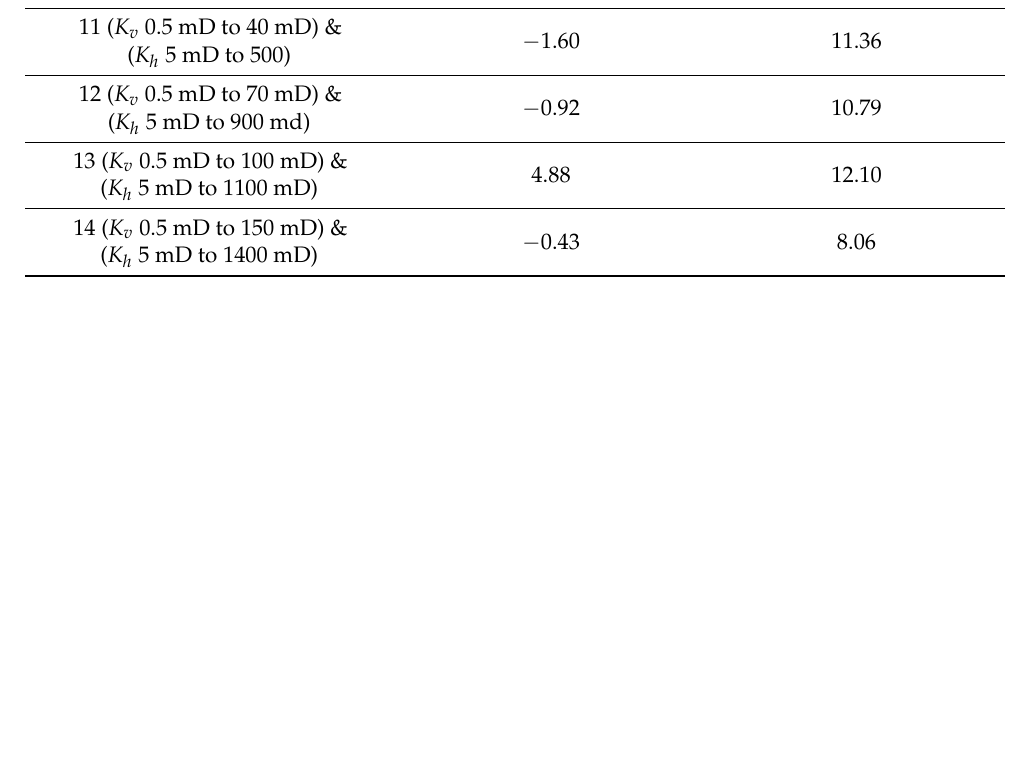
Table 3. Data of increase/decrease of CO 2 dissolution in brine with changing the maximum of the range.